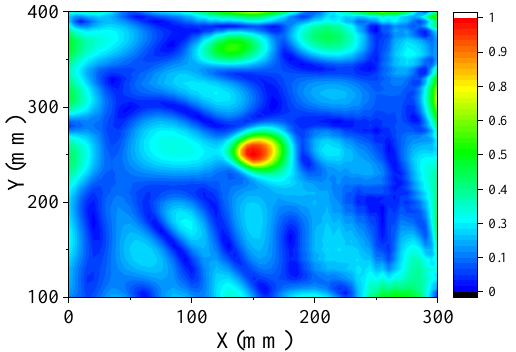
Figure 4. Imaging results of center frequency for a single PIM source.